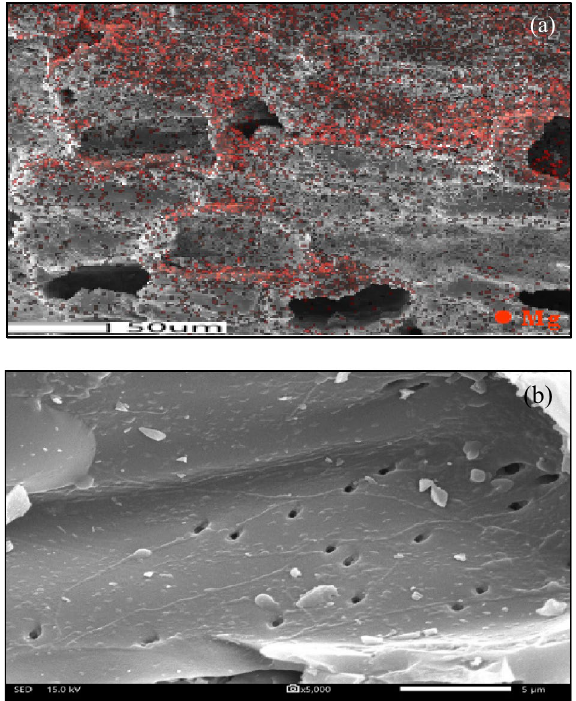
Figure 8. Representative ( a ) metal distribution and ( b ) SEM image of